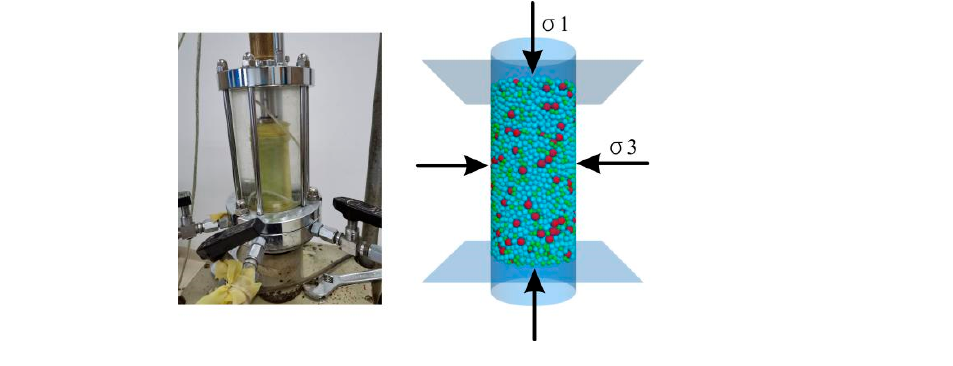
Figure 6. Triaxial test and meso-parameter debugging.